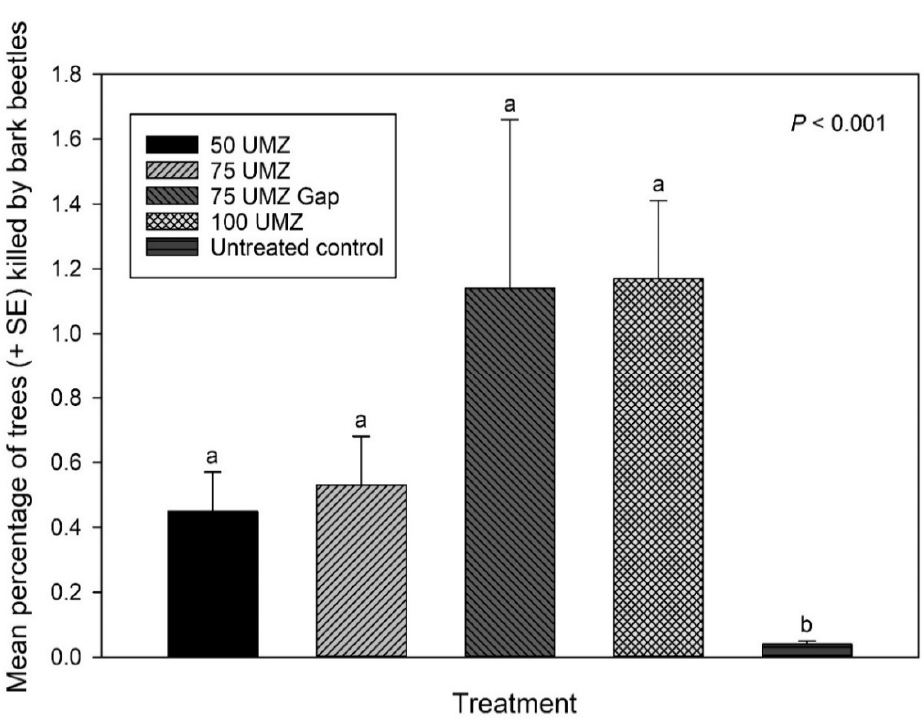
Figure 3. Mean percentage (+SE) of trees killed by bark beetles (all bark beetle species) following thinning and prescribed burning at Pringle Falls Experimental Forest, Oregon. Means (+SE) followed by the same letter are not significantly different ( p > 0.05).